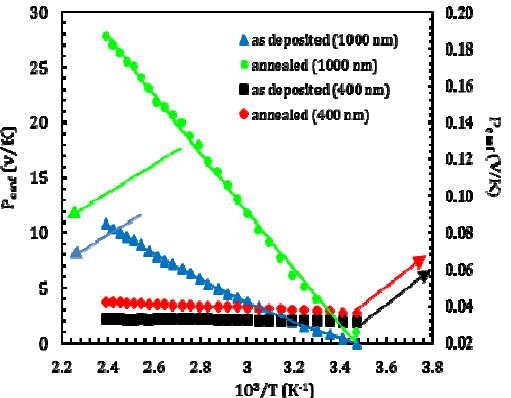
Fig. 2: Electromotive voltage as a function of temperature of as deposited and annealed CdTe films.